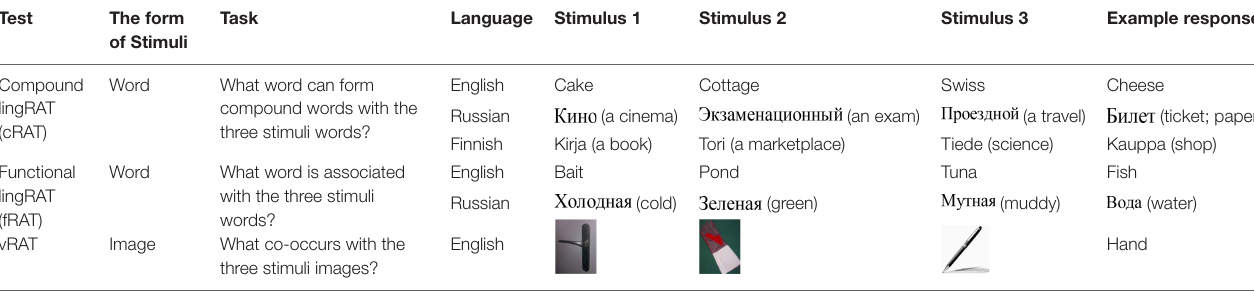
TABLE 1 | Example items of cRAT, fRAT, and